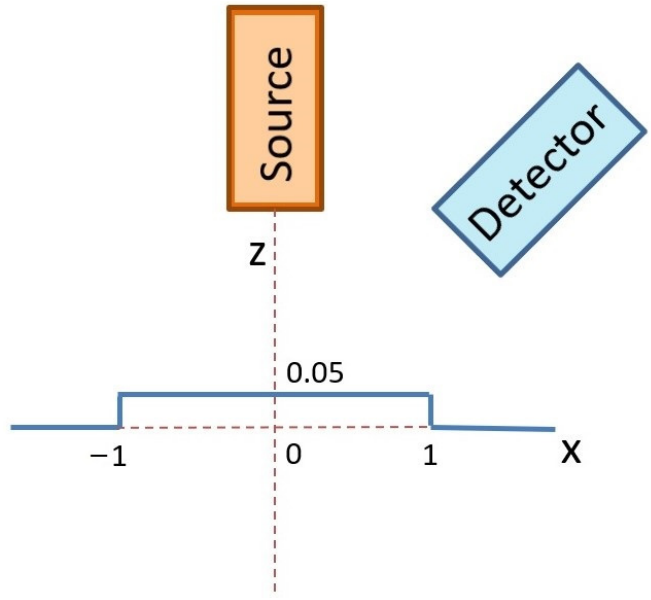
Figure 11. Scheme of Monte Carlo simulation of XRF scanning of an artifact represented by two sharp edges with a height of 0.05 mm.